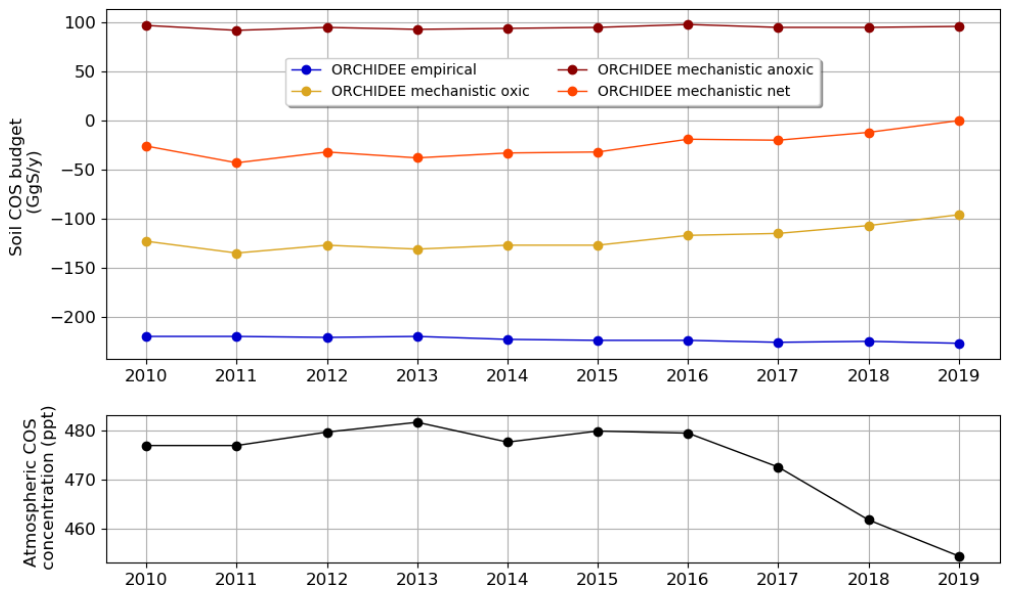
Figure 8. Evolution of mean annual soil COS budget and mean annual atmospheric COS concentration between 2010 and 2019, computed with a variable atmospheric COS